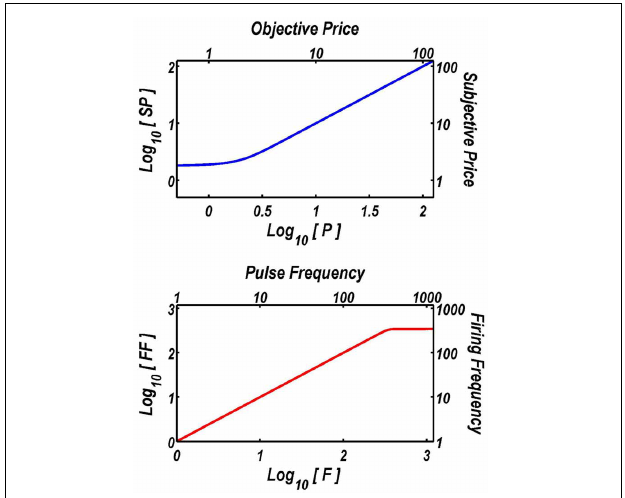
FIGURE 1 | Extensions of the reward-mountain model. The upper graph shows the function that translates objective prices into subjective ones. The form and parameters of this “subjective-price” function are based on an experiment by Solomon et al. (2007). When prices are very low, changes in their objective value have little subjective impact. In contrast, once the price exceeds about 4s, the subjective price converges on the objective price. The lower graph shows the function that translates the pulse frequency into the induced frequency of firing in the directly stimulated neurons subserving the rewarding effect of the electrical stimulation. The form and parameters of this “frequency-following” function are based on another experiment by Solomon et al. (2010). As long as the pulse frequency is lower than about 340 pulses per second, each stimulation pulse triggers an action potential in the directly stimulated neurons. The frequency-response function then levels off quite abruptly, and increasing the pulse frequency further has little